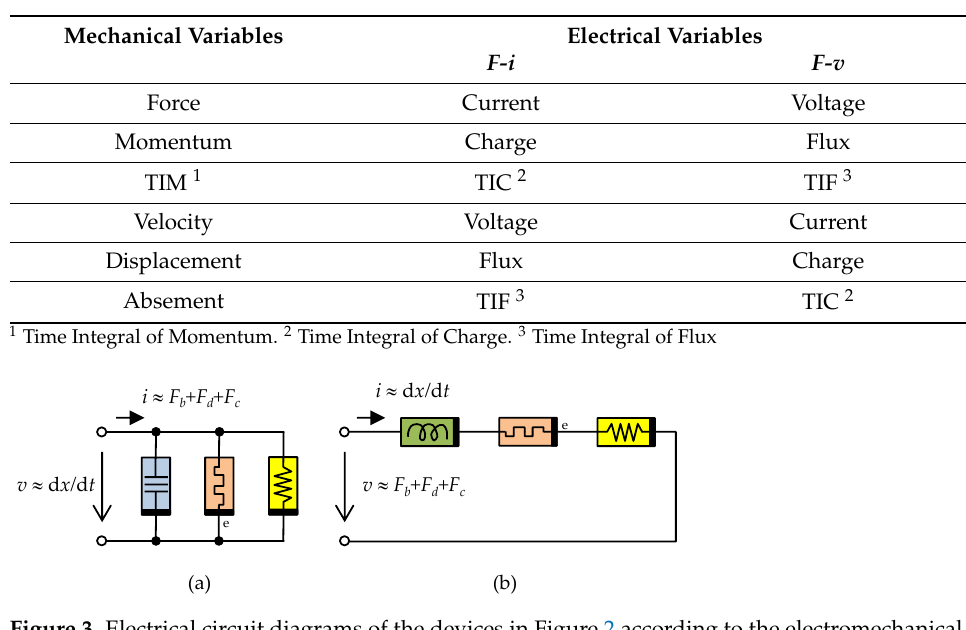
Table 2. Electromechanical F-i and F-v analogies.